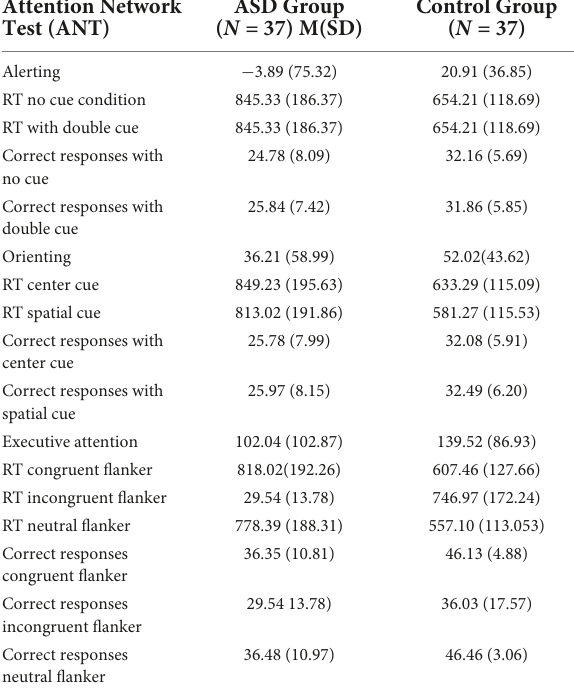
RT-reactiontime. Figure1 .ExperimentalprocedureoftheANTwithfourcueconditions